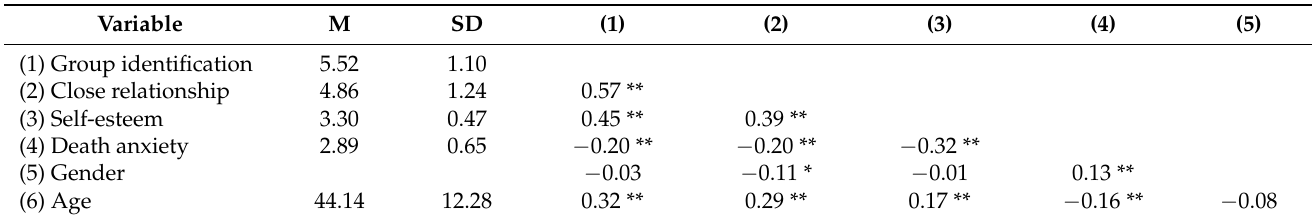
Table 1. Bivariate correlations, means, and standard deviations of the variables (N =